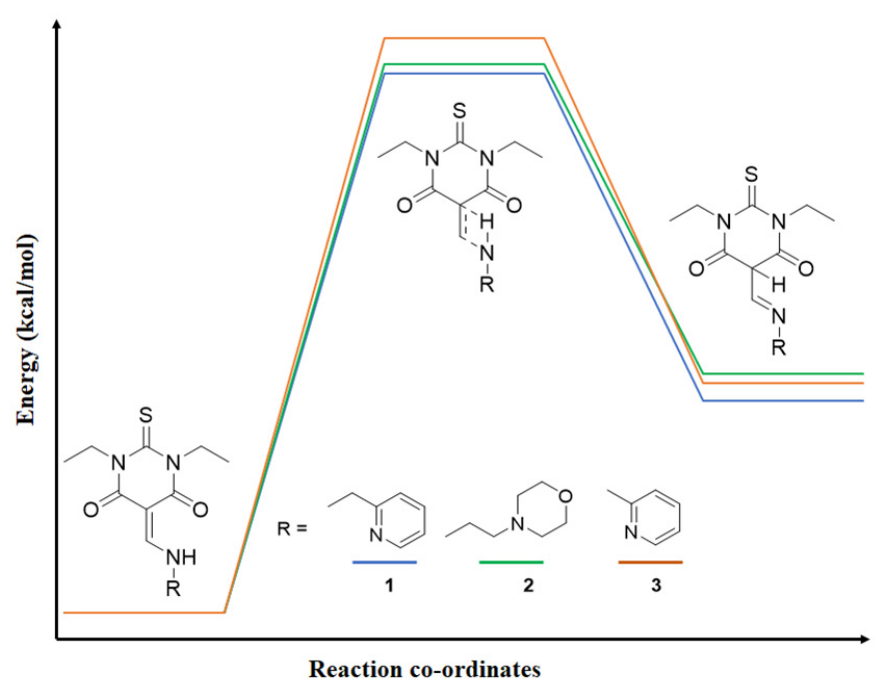
Figure 12. Transition state for intramolecular conversion for all compounds 1 – 3 .